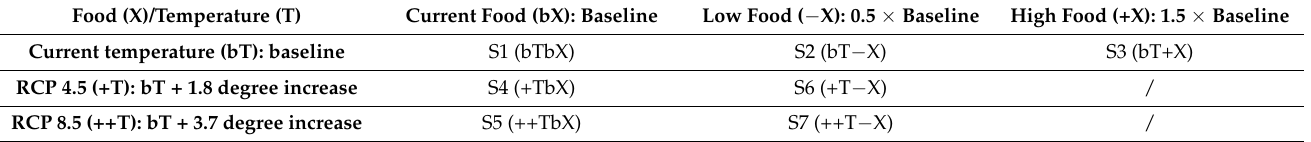
Table 1. List of simulated scenarios (S1–S7) designed to reflect potential changes in temperature (warming of 1.8 and 3.7 degrees—RCP 4.5 and RCP 8.5, respectively, IPCC, 2014), and decrease and increase in food availability, both relative to the baseline, i.e., current conditions. Current (baseline) temperature is assumed to reflect the average seasonal fluctuations in typical coastal sea and estuaries inhabited by soles (see subsection ‘Temperature scenarios’ of Methods), and the food availability (X) is assumed to result in scaled functional response f = 0.85 in both species. In each scenario, there are three spawning events: early, middle, and late, the timing of which depends on the